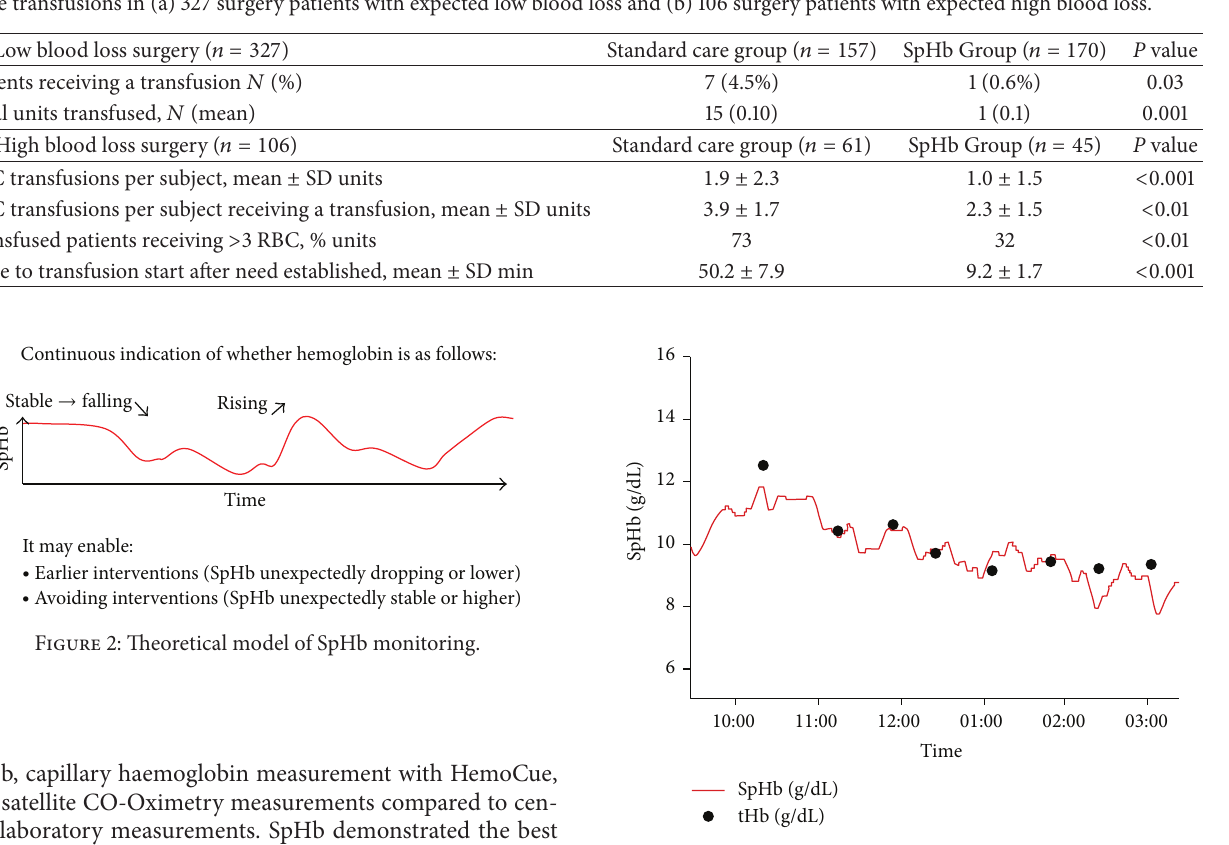
Figure 3: Trend plot of continuous SpHb (red line) and intermittent laboratory haemoglobin values (tHb, black dots) during spine sur- gery in a 69-year-old female patient